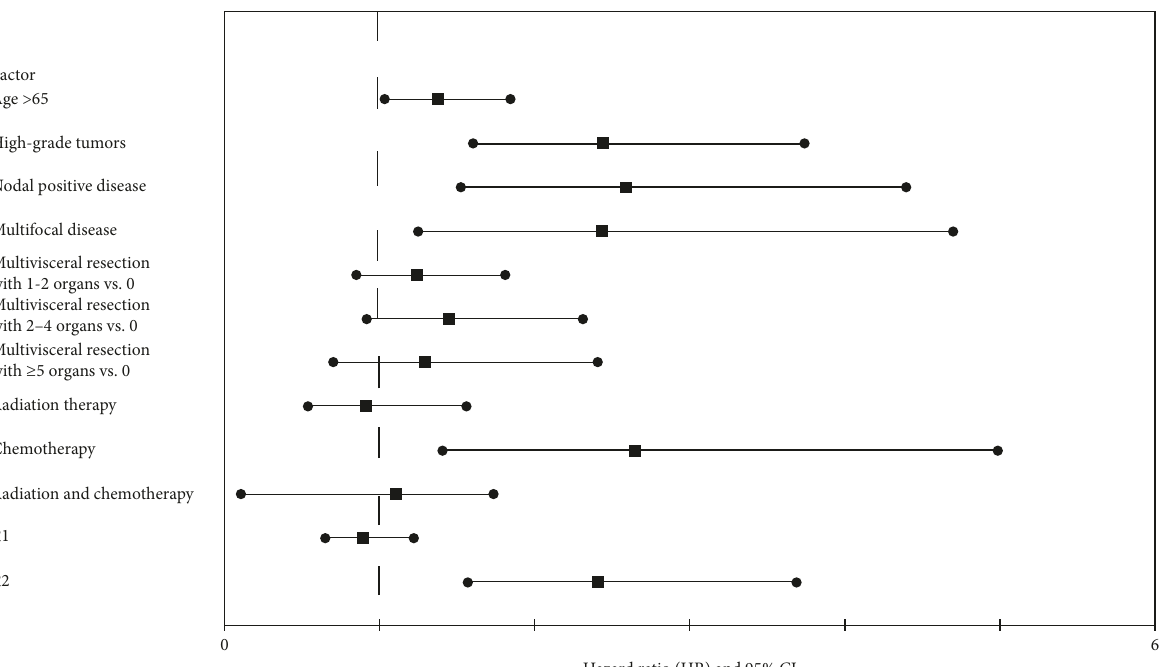
Figure 4: Forest plot demonstrating the hazard ratios and associated 95% confidence intervals for each factor included in the multivariate Cox proportional hazards model for overall